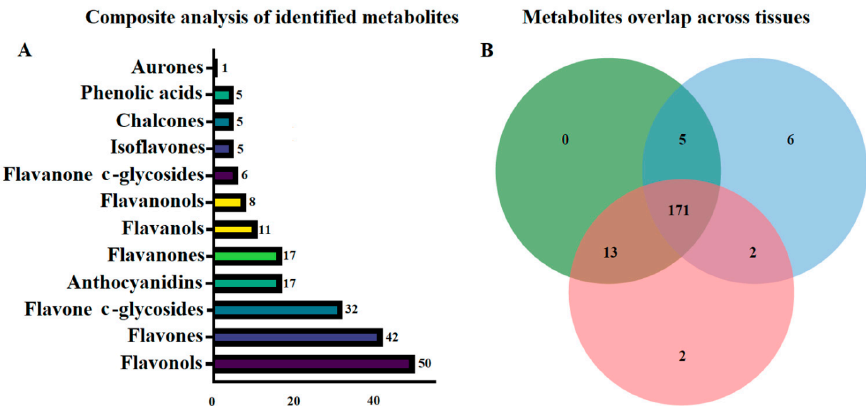
Figure 2. Flavonoids and phenolic acids tentatively identified. ( A ) An integrated view of the identified compounds. The numbers correspond to the compounds in the subclass. ( B ) Metabolites unique or shared among the C. rotundifolia organs. The numbers represent the compounds in each section.